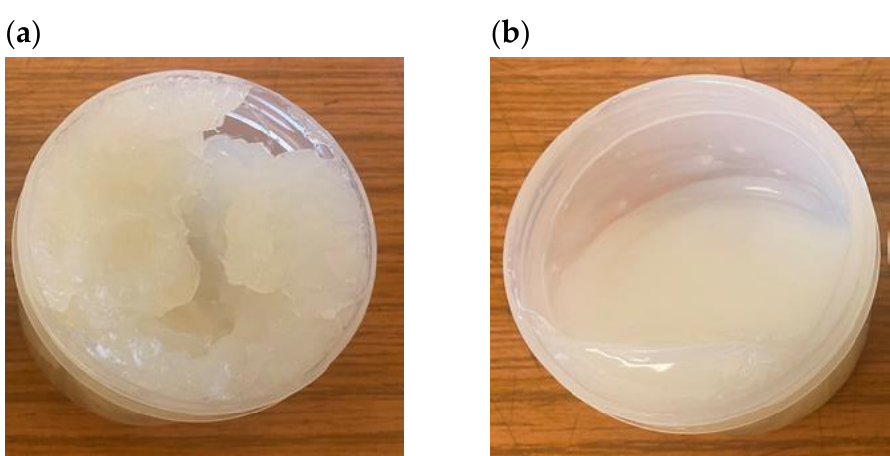
Figure 2. The appearance of the base grease: ( a ) before mixing; ( b ) after mixing in a planetary mixer.